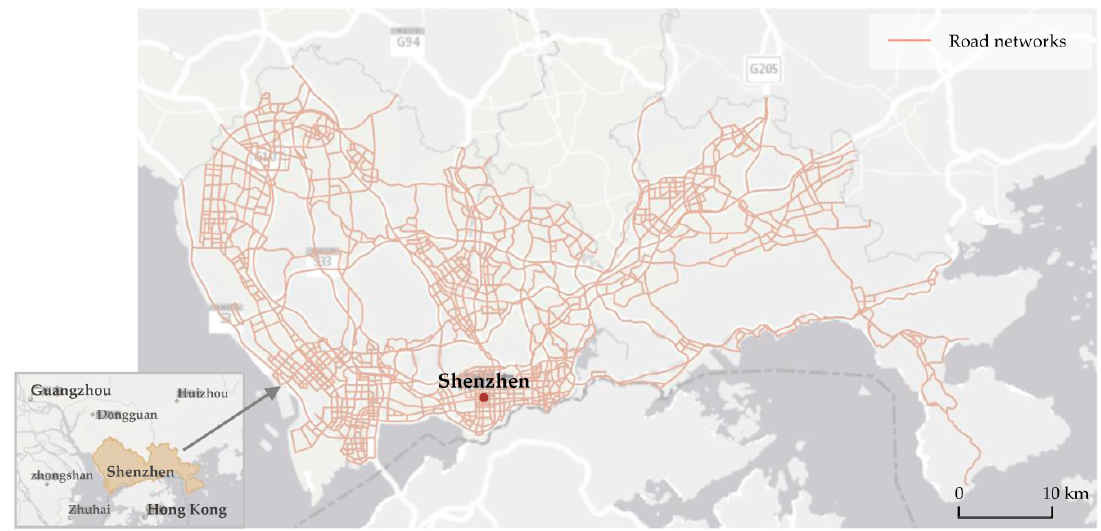
Figure 10. The study area and road networks in Shenzhen.